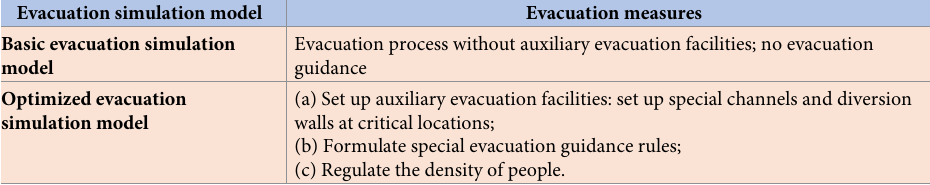
Table 1. Evacuation simulation models under different evacuation measures.